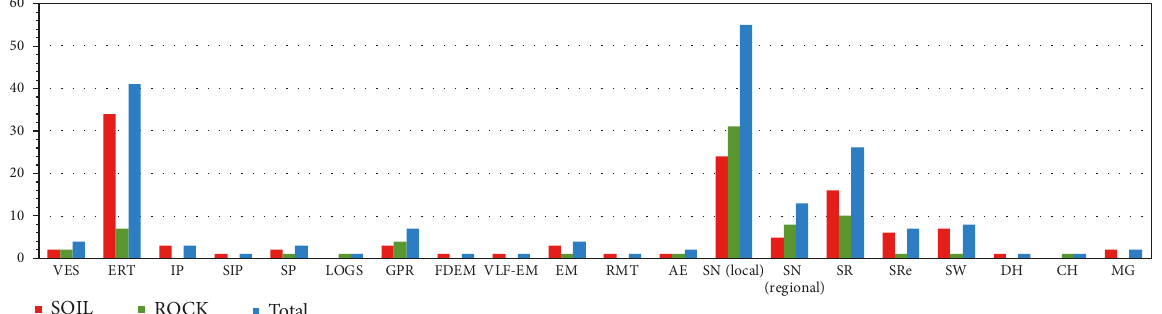
Figure 2: For each landslide typology (“soil” in red, “rock” in green, and total in blue), the bar graph shows the number of papers focused on each geophysical method.